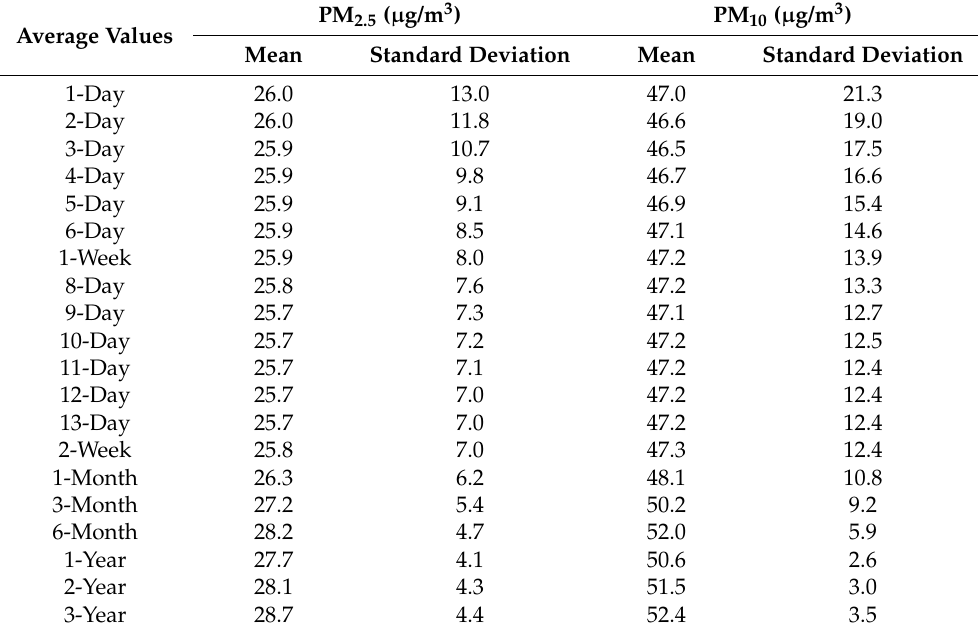
Table 2. Distribution of PM 2.5 and PM 10 levels according to duration of exposure (n = 4175). Average Values